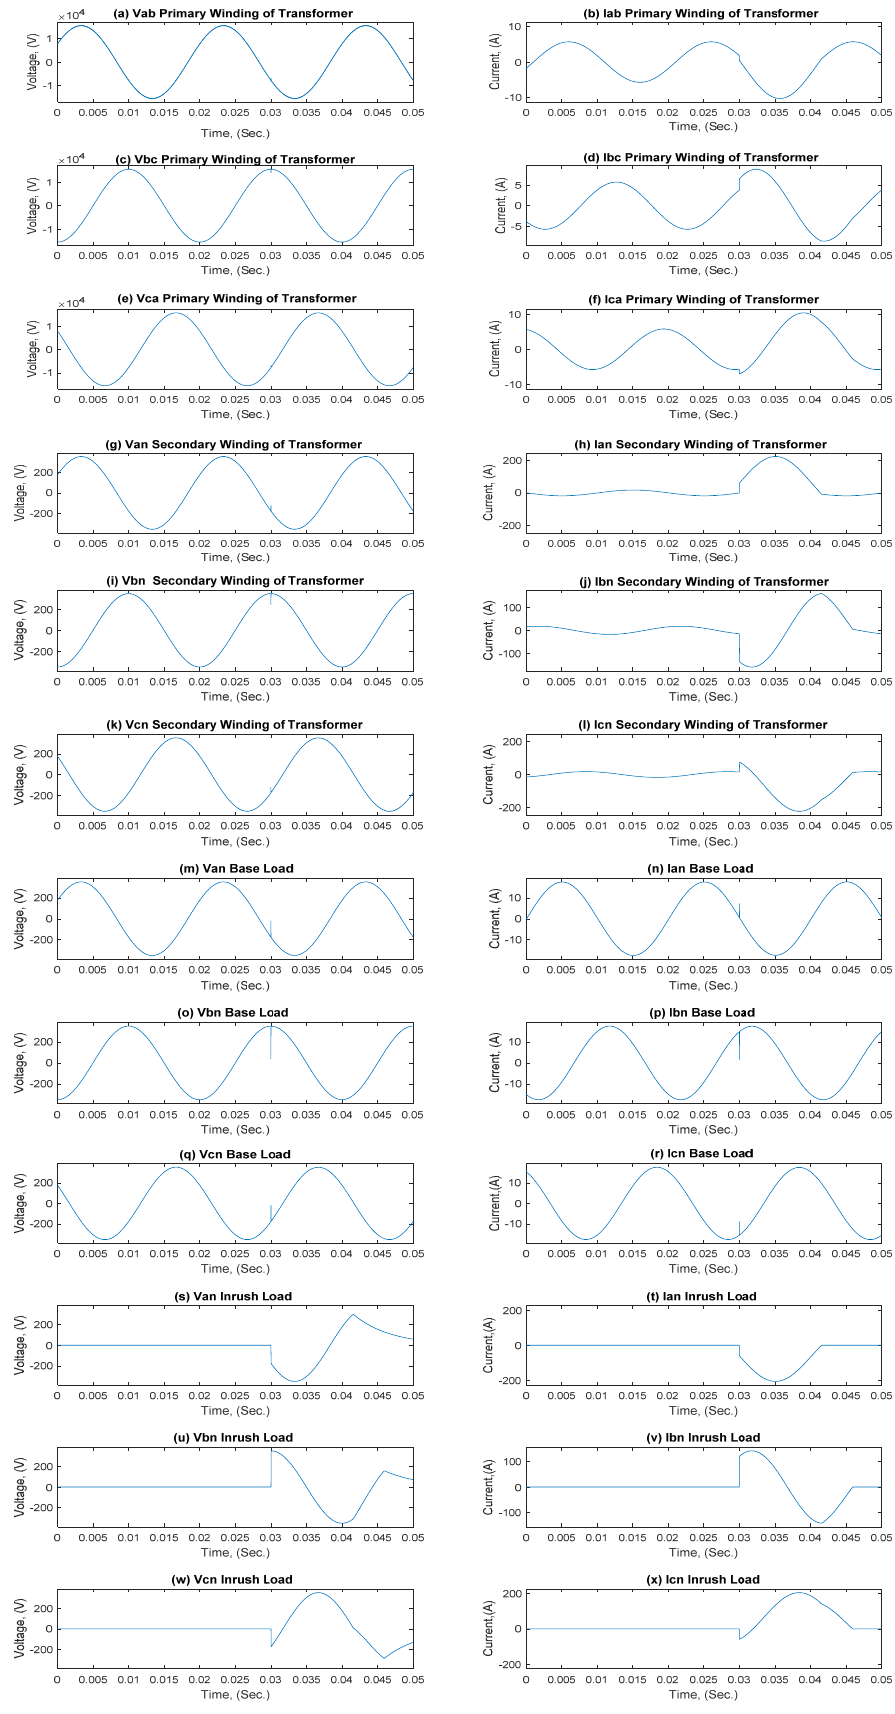
Figure 14. Impact of inrush current with a magnitude of 101 A on the performance of the power system.